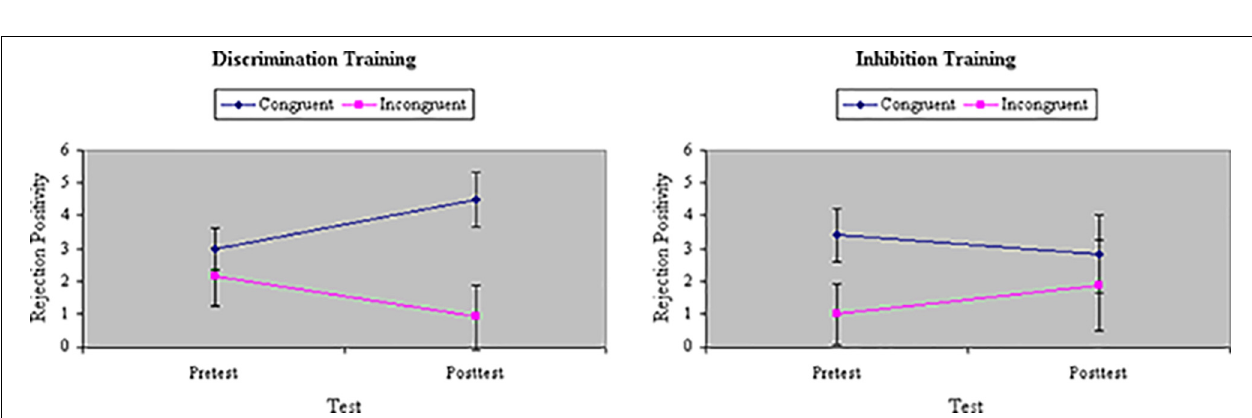
FIGURE 11 | Amplitude of RP ERP component to distractors (in microvolts) on congruent and incongruent trials in the filtering task at pretest and posttest in discrimination and inhibition training groups. Inhibition training increased RP to incongruent stimuli whereas discrimination training significantly decreased RP to incongruent